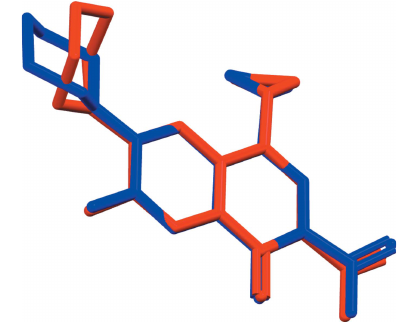
Figure 3 Molecular overlay of ciprofloxacin cation in compounds (I) (red) and (II) (blue). Hydrogen atoms are omitted for clarity.